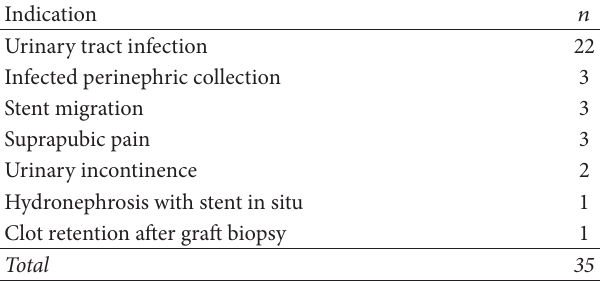
Table 2: Indications for urgent USS after elective stent